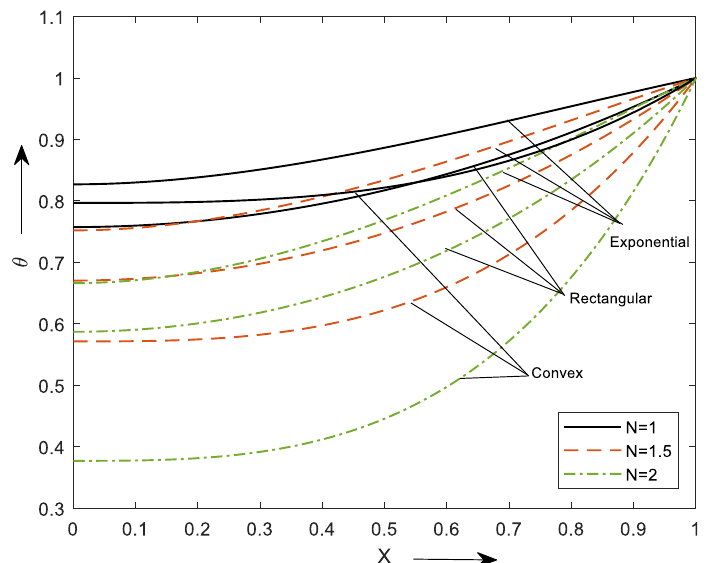
Figure 4. Temperature distribution of different profiles for diverse values of N . The effect of the internal heat generation parameter